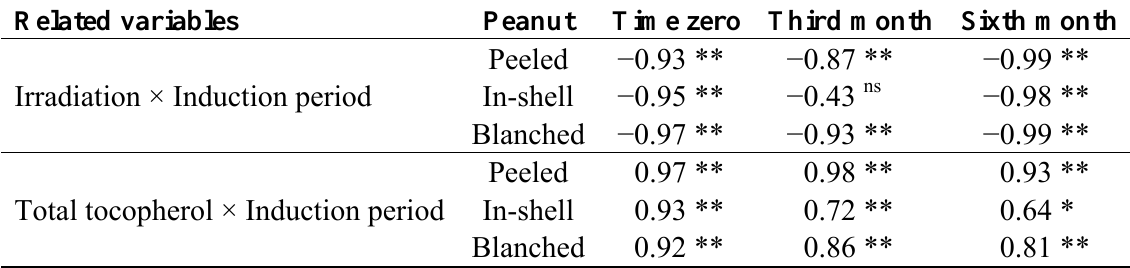
Table 6. Pearson’s correlation between gamma radiation and induction period and between total tocopherol and induction